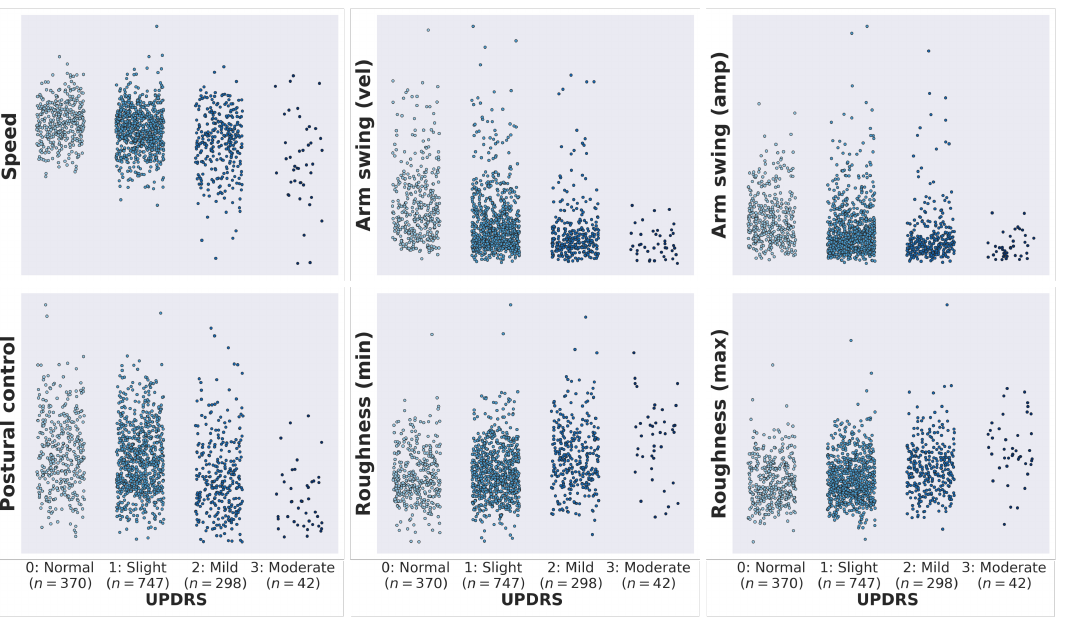
Figure 5. Distribution of the six features by clinical UPDRS gait (item 3.10) rating. For each of the six features, a one-way ANOVA test found a highly significant ( p < 0.001) difference in means between the clinical UPDRS groups. All features were significantly correlated with total UPDRS part-III scores (see Table 2 and Figure 6).